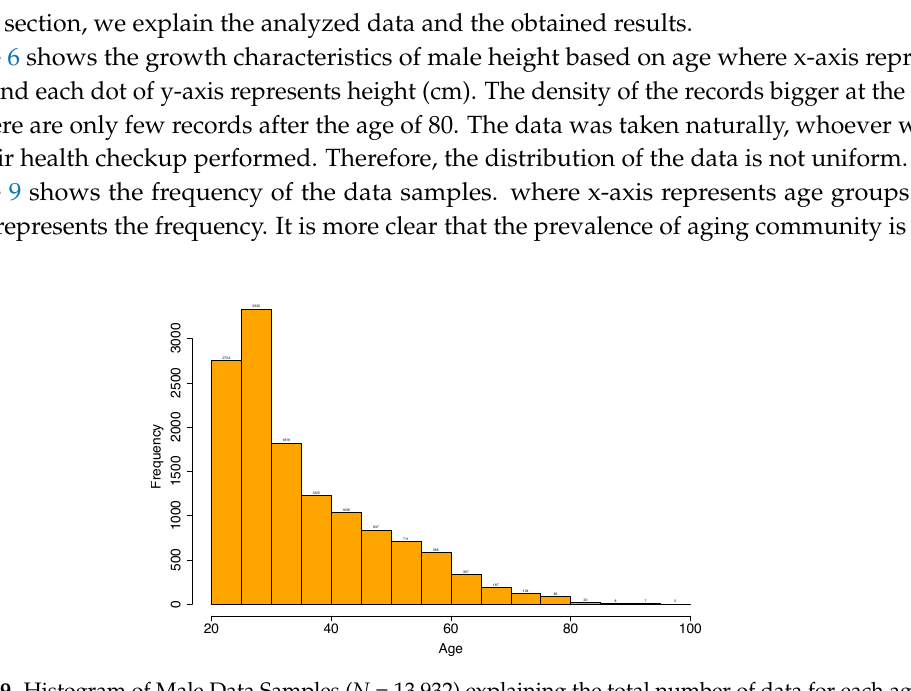
Figure 9. Histogram of Male Data Samples ( N = 13,932) explaining the total number of data for each